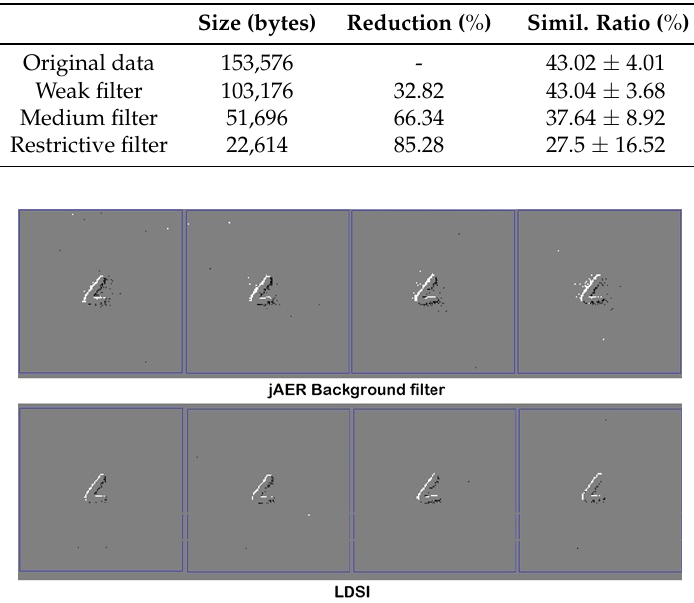
Figure 13. Filtering result for the background filter algorithm included in jAER software ( top ) and LDSI result ( bottom ).